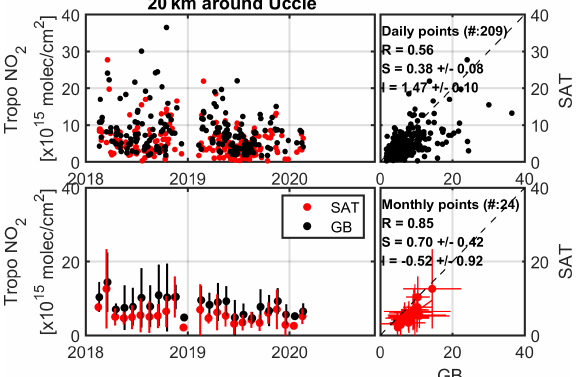
Figure 22. Daily (grey dots) and monthly mean (black dots) ab- solute and relative TROPOMI (SAT) and MAX-DOAS (GB) time series differences for the Uccle station. Results are shown for the improved satellite retrieval algorithm. The histogram of the daily differences is also given, showing the mean and median difference. The total mean values of absolute and relative monthly differences are given in the bottom-right